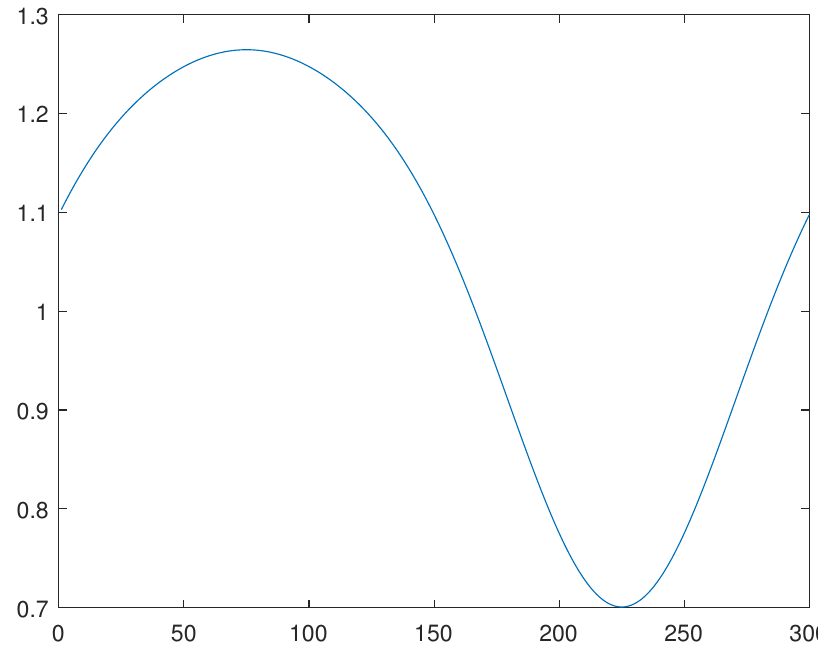
Figure 9. Line 6, solution u 6 ( x ) through the minimization of functional J .